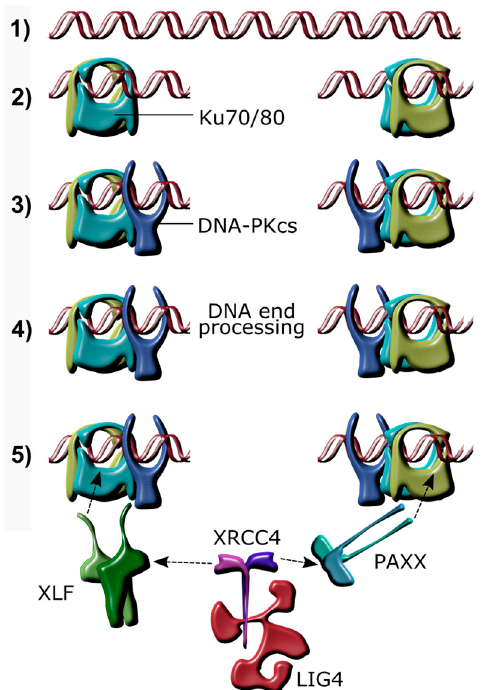
Figure 1. Schematic overview of non-homologous end joining after a DNA double strand break. ( 1 ) Linear DNA; ( 2 ) A double strand break (DSB) caused by genotoxic damage is bound by the Ku70/80 heterodimer, which slides along the DNA to make room for subsequent complex formation; ( 3 ) DNA- dependent protein kinase, catalytic subunit (DNA-PKcs) binds to the Ku70/80 heterodimer; ( 4 )